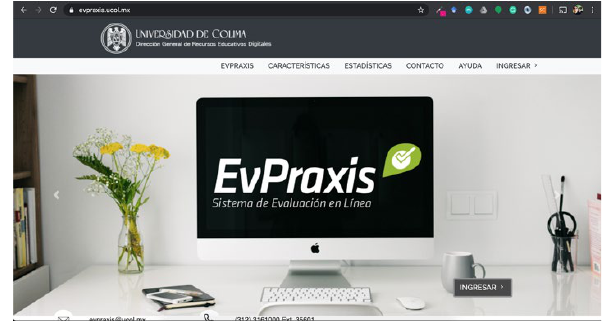
Figure 7. EvPraxis home page.